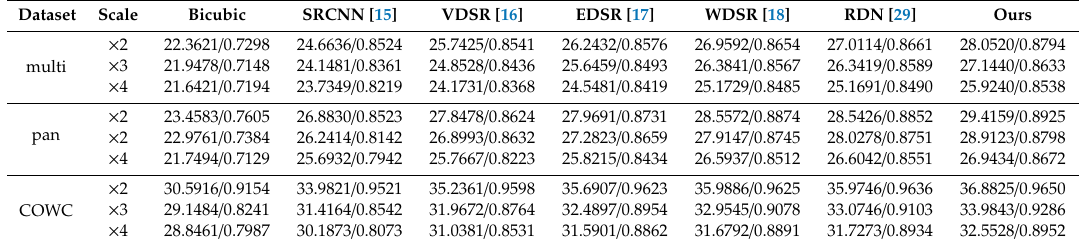
Table 3. Average PSNR / SSIM results at scales × 2, × 3, and × 4 on our GF-2 datasets and the COWC datasets. The red color indicates the best performance.